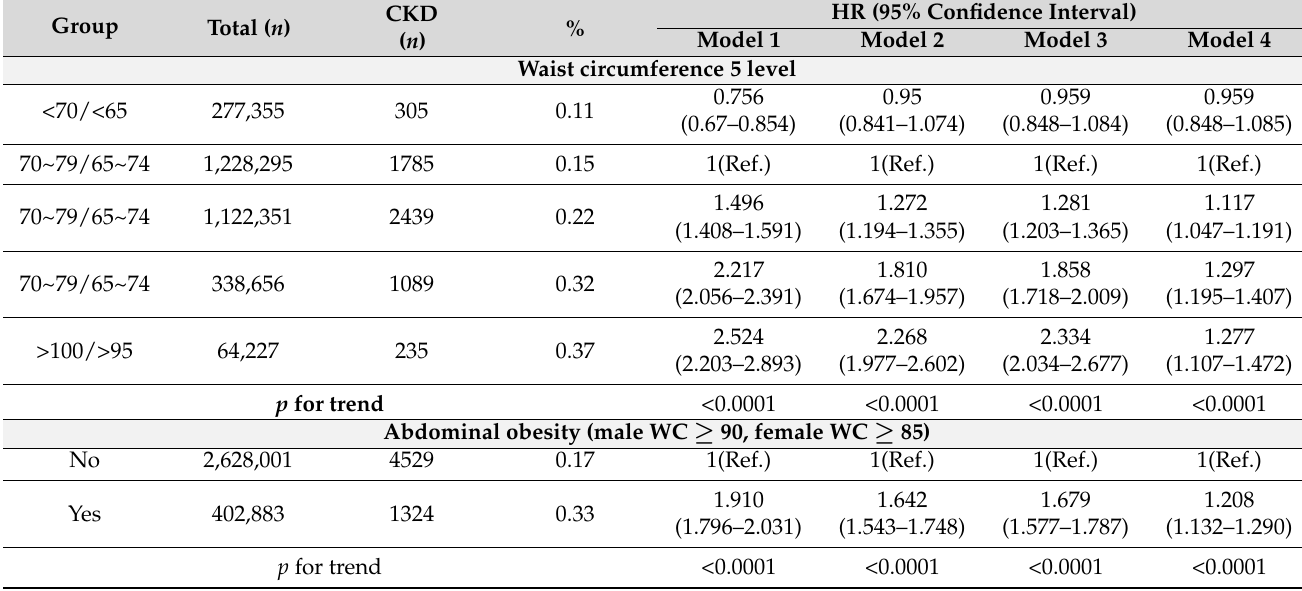
Table 5. Multivariate cox analysis for incident CKD by level of waist circumference in young adults.